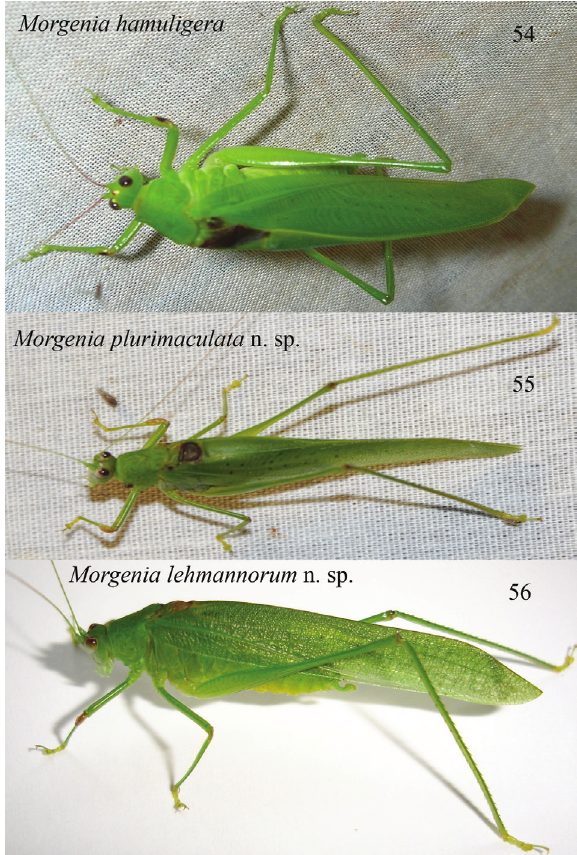
Figures 54–56. Living specimens of Morgenia hamuligera from Central African Republic, Dzanga-Ndoki National Park ( 54 ; photo by P. Annoyer), M. plurimaculata sp. n. from Central African Republic, Dzanga-Ndoki National Park ( 55 ; photo by S. Danflous) and M. lehmannorum sp. n. from Uganda, Semliki Forest National Park ( 56 ; photo by K-G